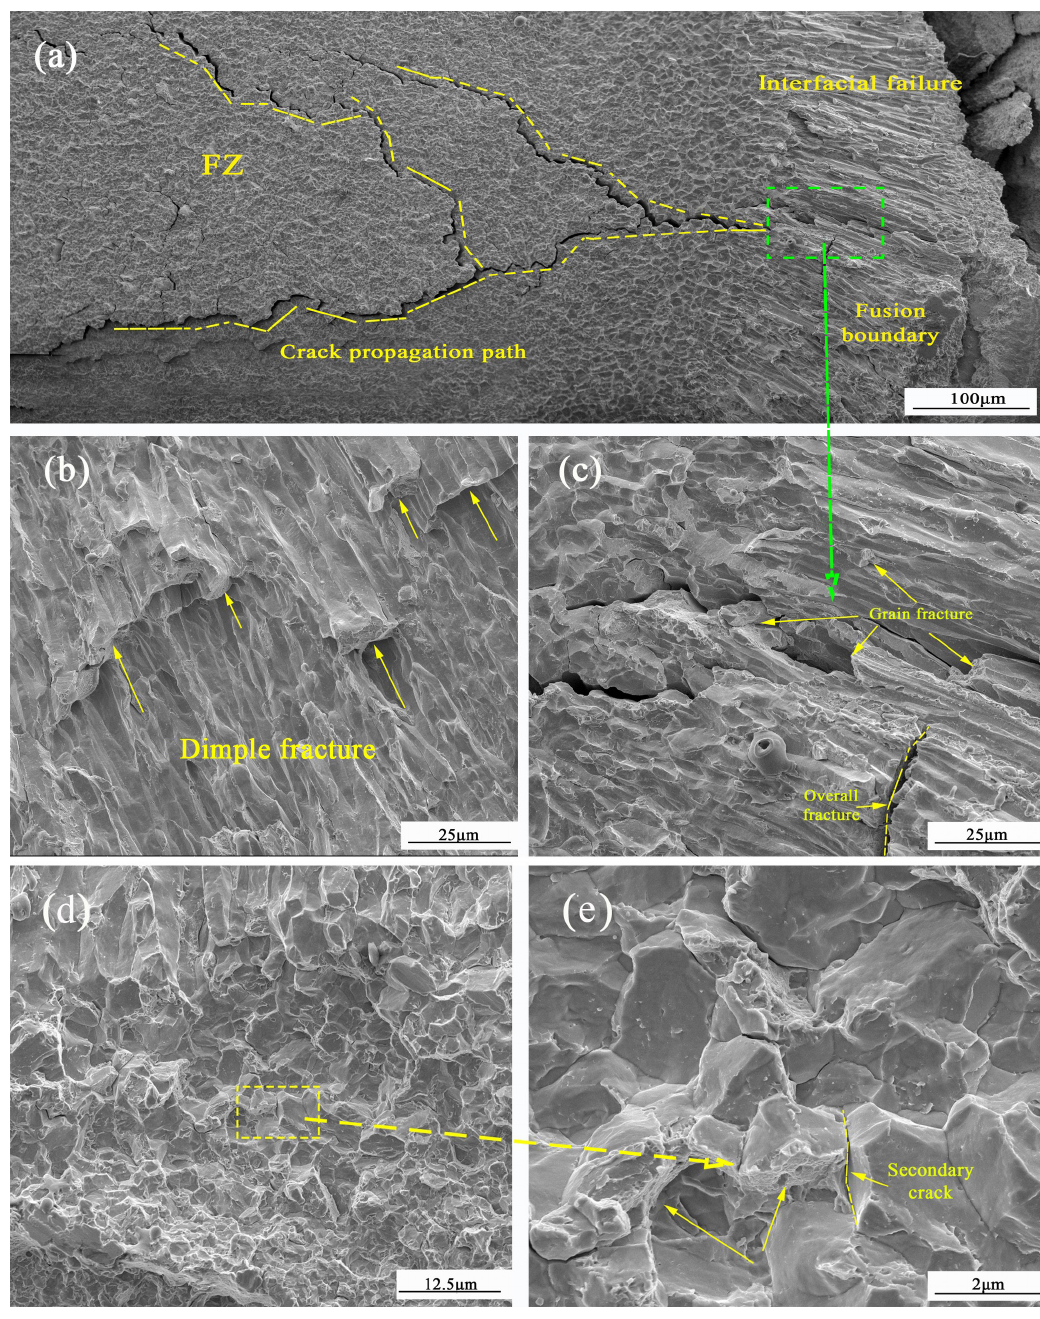
Figure 6. Fracture morphology corresponding to interface failure: (a) crack propagation path; (b) fracture morphology of nugget boundary; (c) crack terminal magnification; (d) fracture morphology of heat affected zone; (e) amplification morphology of frame-line